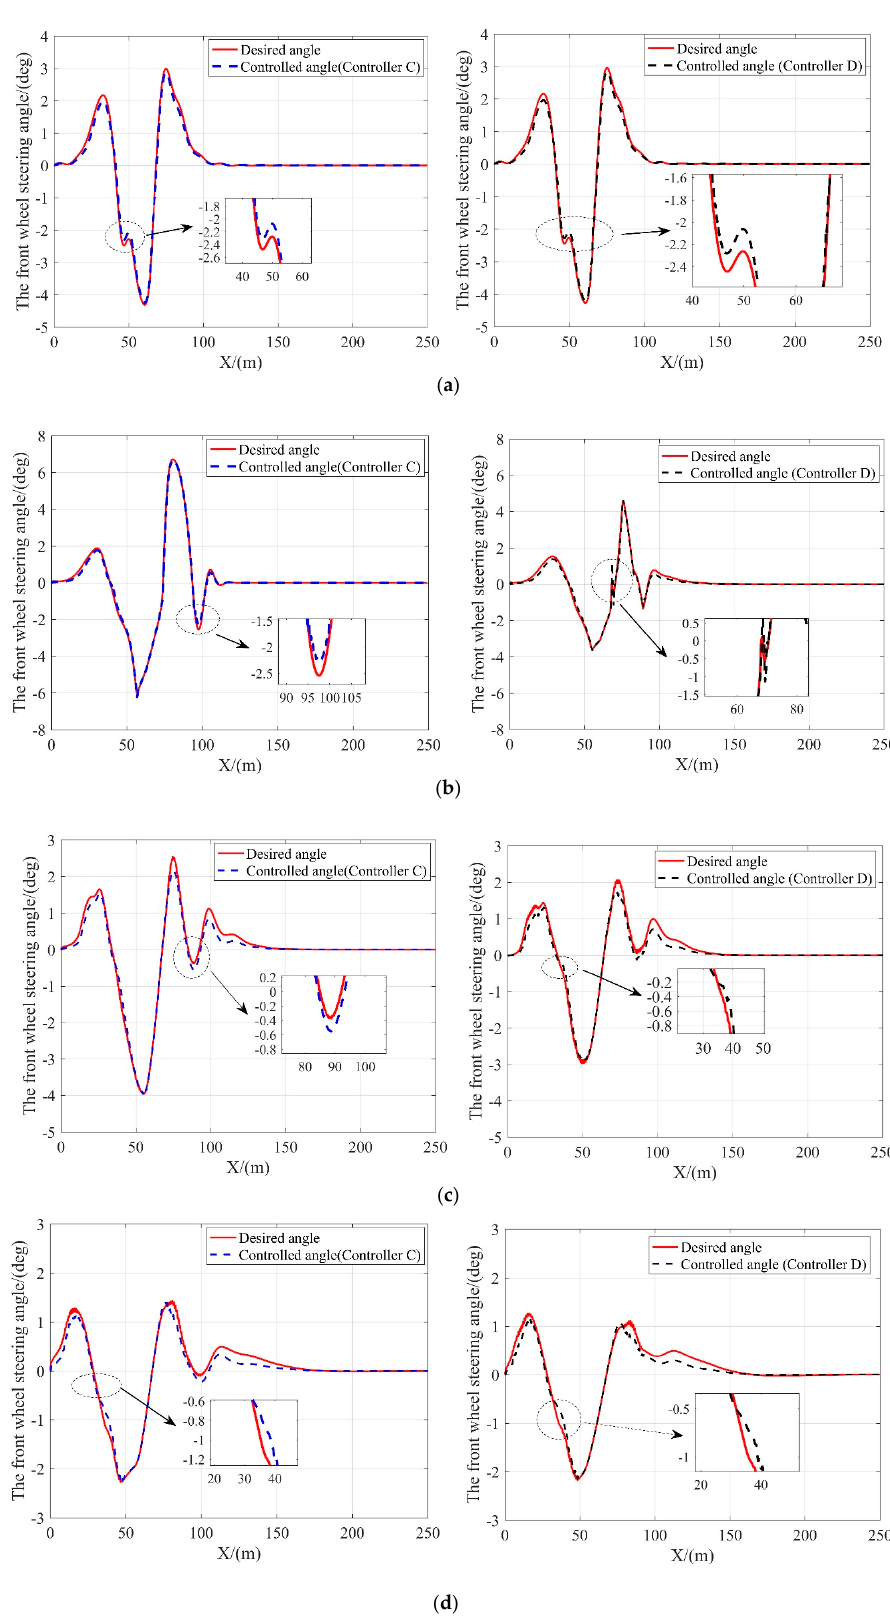
Figure 10. The desired and controlled steering angle of the front wheel with the controller C and D at different vehicle velocities. ( a ) 10 m/s; ( b ) 15 m/s; ( c ) 20 m/s; ( d ) 25 m/s.